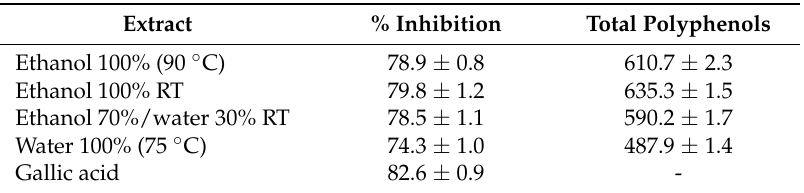
Table 2. Antioxidant activity, expressed as % ± SD ( n = 6) of 2,2-diphenyl-1-picrylhydrazyl (DDPH) inhibition, and the total content of polyphenols, expressed as g/Kg ± SD of chestnut shell extracts. The values are the mean of extractions carried out over a period of three